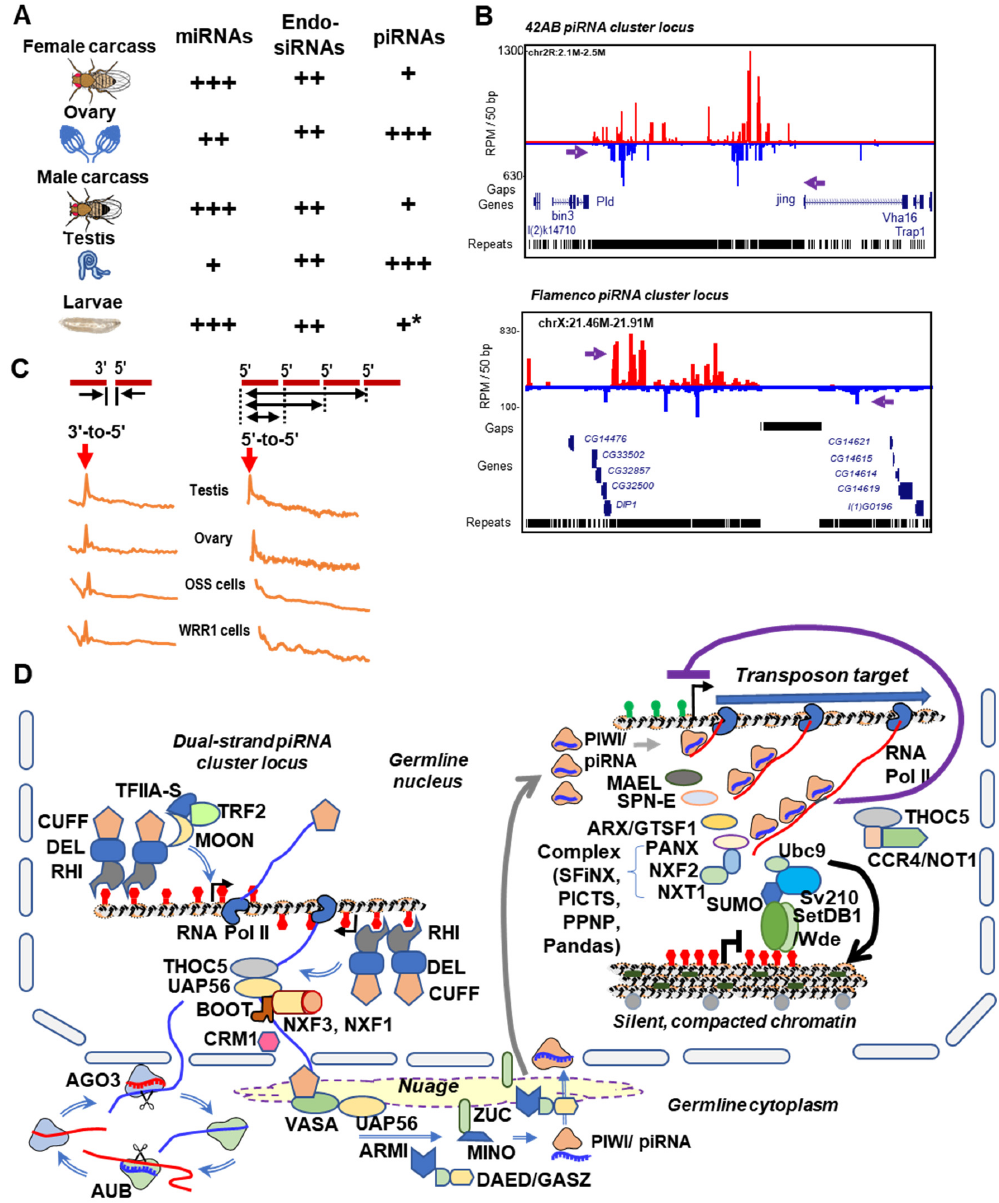
Figure 2. Drosophila -focused Piwi / piRNA pathway features. ( A ) Drosophila piRNA expression is restricted to germline, with an asterisk for piRNAs in larvae libraries that include the larval gonads. ( B ) Configuration of two notable Drosophila piRNA cluster loci, 42AB and flamenco . ( C ) Drosophila piRNA phasing patterns analyses with red arrows pointing to salient signature of piRNAs juxtaposed to each other from the precursor transcript. ( D ) Schematic of Drosophila -specific Piwi / piRNA pathway silencing complexes such as the Rhino-Deadlock-Cutoff complex that promotes piRNA biogenesis from the 42AB locus (left) and a transcriptional gene silencing network (right; various names like SFiNX, PICTS, PNPP, Pandas complex) and Sv210 and CCR4/NOT1 complex that target transposon silencing at the chromatin level in the nucleus.